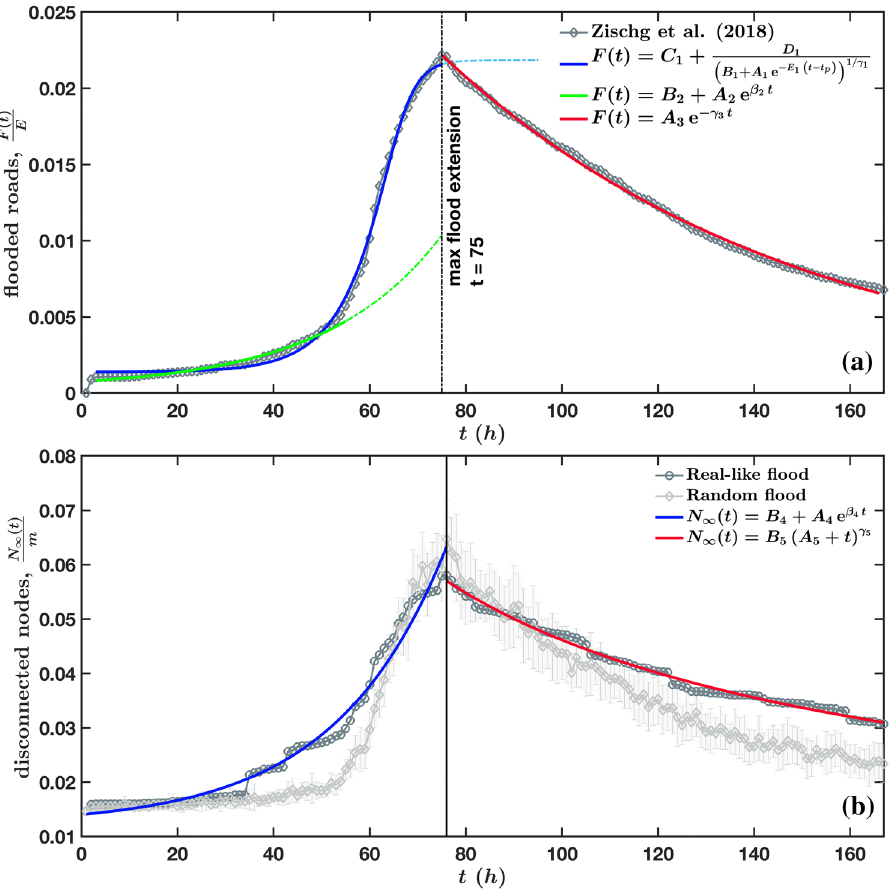
Figure 2. ( a ) Time evolution of the number of flooded roads, F ( t ). During the Zischg et al. 51 simulations, roads were marked as flooded if the water depth was greater than 0.3 m, which is considered as the limit of water’s depth for driving a car (with average ground clearance) 56 . In terms of number of flooded roads, the earliest times of the flooding event are well characterised by an exponential growth. However, this function does not describe the saturation phase here observed, which is instead typical of logistic-like functions. A fair approximation of the entire growing phase is given by a generalised logistic function, which fits particularly well the saturation phase, up to the maximum flood extension. The recovery phase, that is the phase of flood withdraw, follows instead a slow exponential decay. ( b ) Time evolution of the number of disconnected nodes, N ∞ ( t ) . This metric is here illustrated for both the real-like flood simulated by Zischg et al. 51 and the randomly generated flood. For the real-like flood, the dynamics of N ∞ ( t ) is well approximated by an exponential growth and decay, respectively for the increasing and recovery phases of the flood. Although both N ∞ ( t ) —calculated for the two types of floods—reach a similar peak at t MFE , the number of nodes which disconnect from the rest of the network is generally larger for real-like floods than in random floods, in both phases of flood’s increase and withdraw. This occurs since real-like floods are more spatially concentrated (i.e. less dispersed) than random floods, with a higher probability of surrounding and isolating nodes. Therefore, modelling and simulating a flood event with a random blockage of roads would be misleading, generally resulting in an underestimation of N ∞ ( t ) , in several moments of a flooding event. This figure was produced with Matlab 55